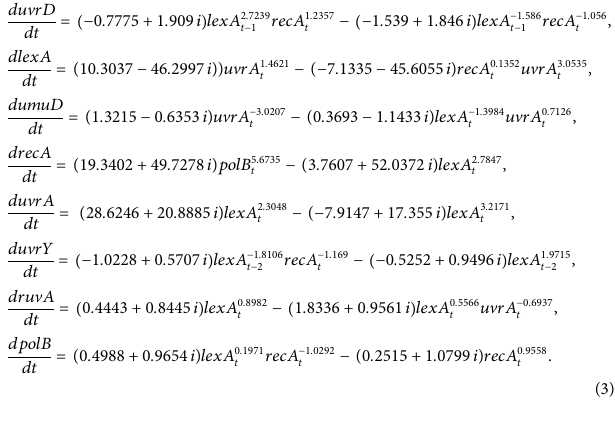
corresponding optimal CVTDSS models of eight target genes have been obtained in order to reduce the false- positive regulations and prune the network structures, which are described in Eq. 3 . The fi nal SOS repair network is obtained in Figure 6B , according to our proposed method. Figure 6A is the network obtained by CVTDSS without TDCC. The solid lines represent true-positive regulations, while dotted lines show the false-positive relationships.